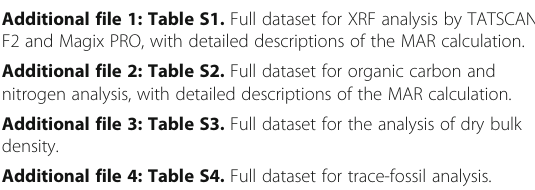
Additional file 3: Table S3. Full dataset for the analysis of dry bulk density. Additional file 4: Table S4. Full dataset for trace-fossil